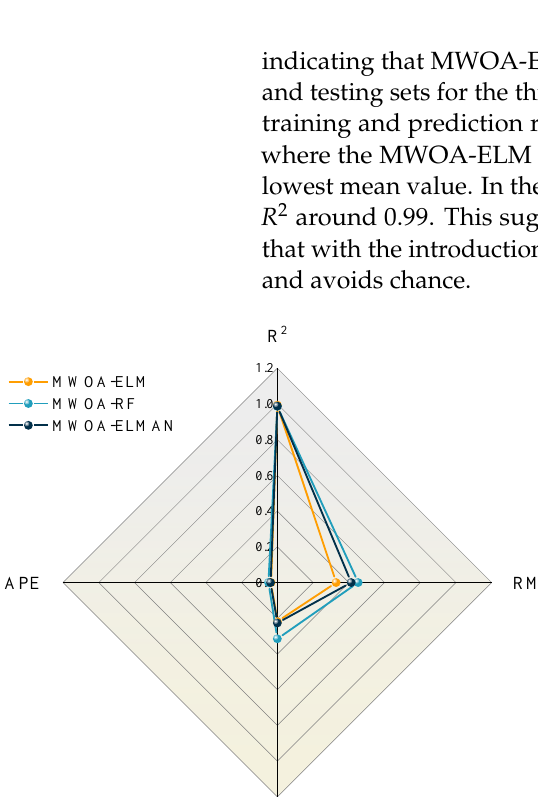
Figure 11. Radar plots of metrics for the Training ( a ) and Testing ( b ) sets for MWOA-ELM, MWOA-RF, and MWOA-ELMAN models.